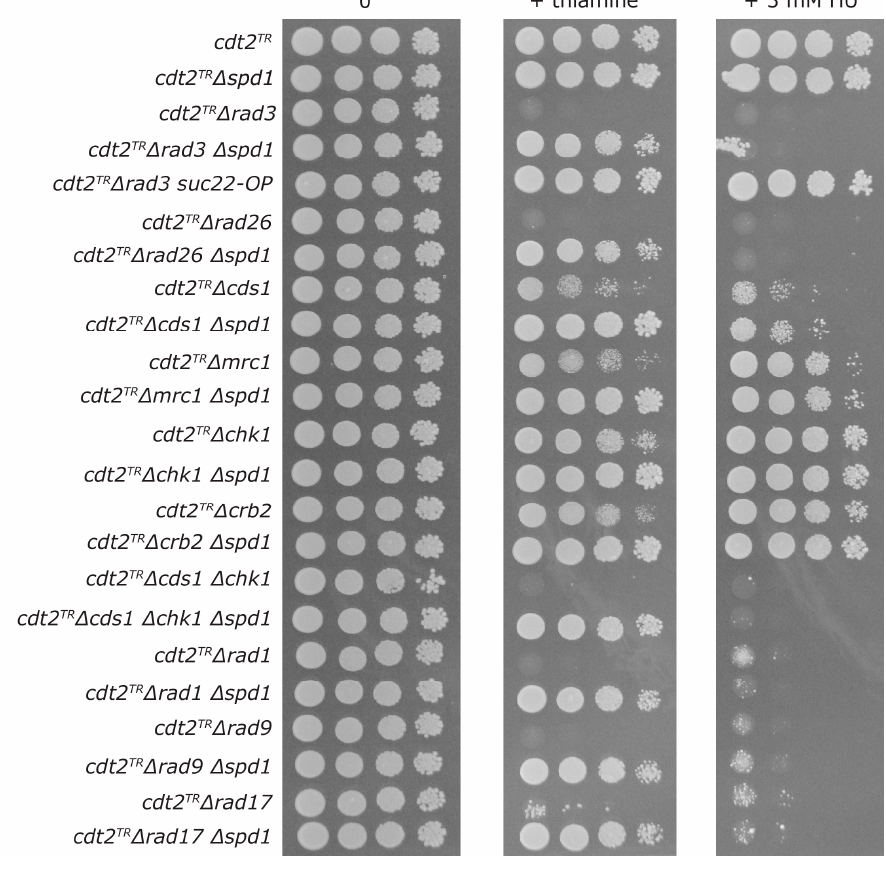
Figure 3. Checkpoint requirement in Spd1 accumulating cells. Cells of the indicated genotype (all salvage background) were spotted onto MSA plates either without or with thiamine, or plates containing 3 mM hydroxyurea (HU). The plates were incubated at 30 °C for three